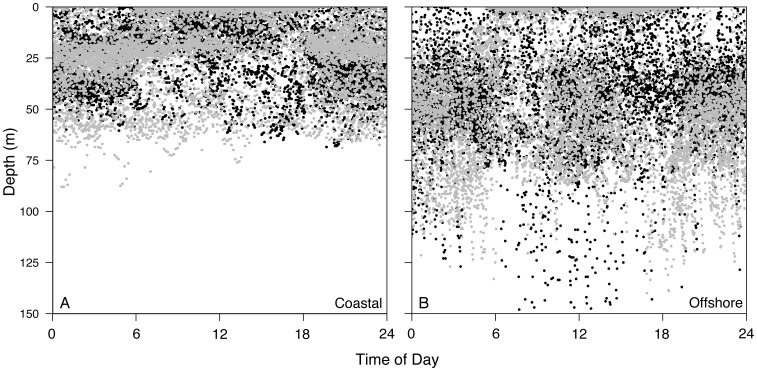
Coastal and offshore diel diving behavior.Combined diel diving behavior for MA111 (grey) and MA112 (black) during coastal (A) and offshore (B) habitat occupation. Note y-axis is truncated in (B) to facilitate comparison.